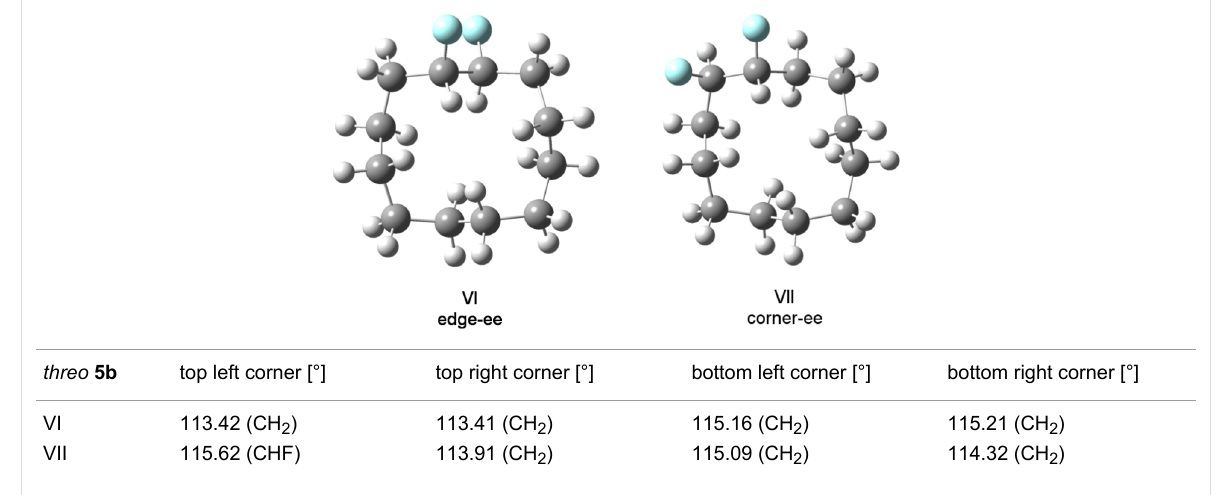
Table 2: The corner C–C–C angles for conformers VI and VII of the threo isomer 5b . The C–CHF–C angle (115.62°) is the largest; however some C–CH 2 –C angles are clearly strained at